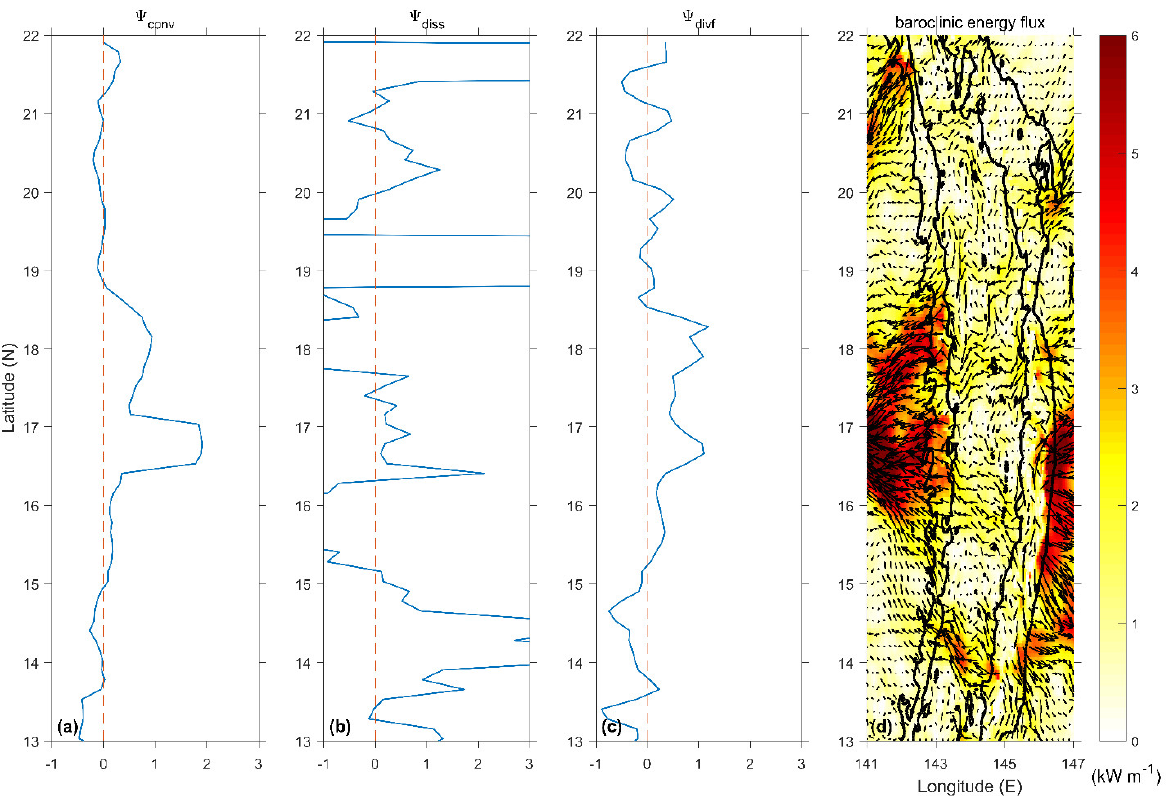
Figure 12. The zonally integrated amplification of the conversion ( a ), dissipation ( b ), and divergence ( c ) at the Mariana double ridges. Depth-integrated baroclinic energy flux (vector) and its magnitude (color shading) (kW m –1 ) at the double ridges ( d ). The background contours represent the 3000-m isobaths.